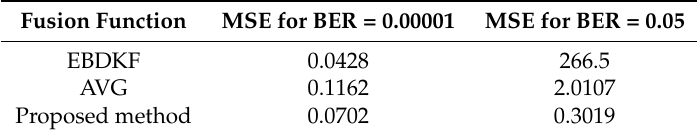
Figure 10. The performance comparison among the proposed statistical, AVG and EBDKF for a dynamic system parameter having communication link with ( a ) BER of 0.0001 and ( b ) BER of 0.05. Table 1. Network MSE for a dynamic system parameter for different fusion functions under different